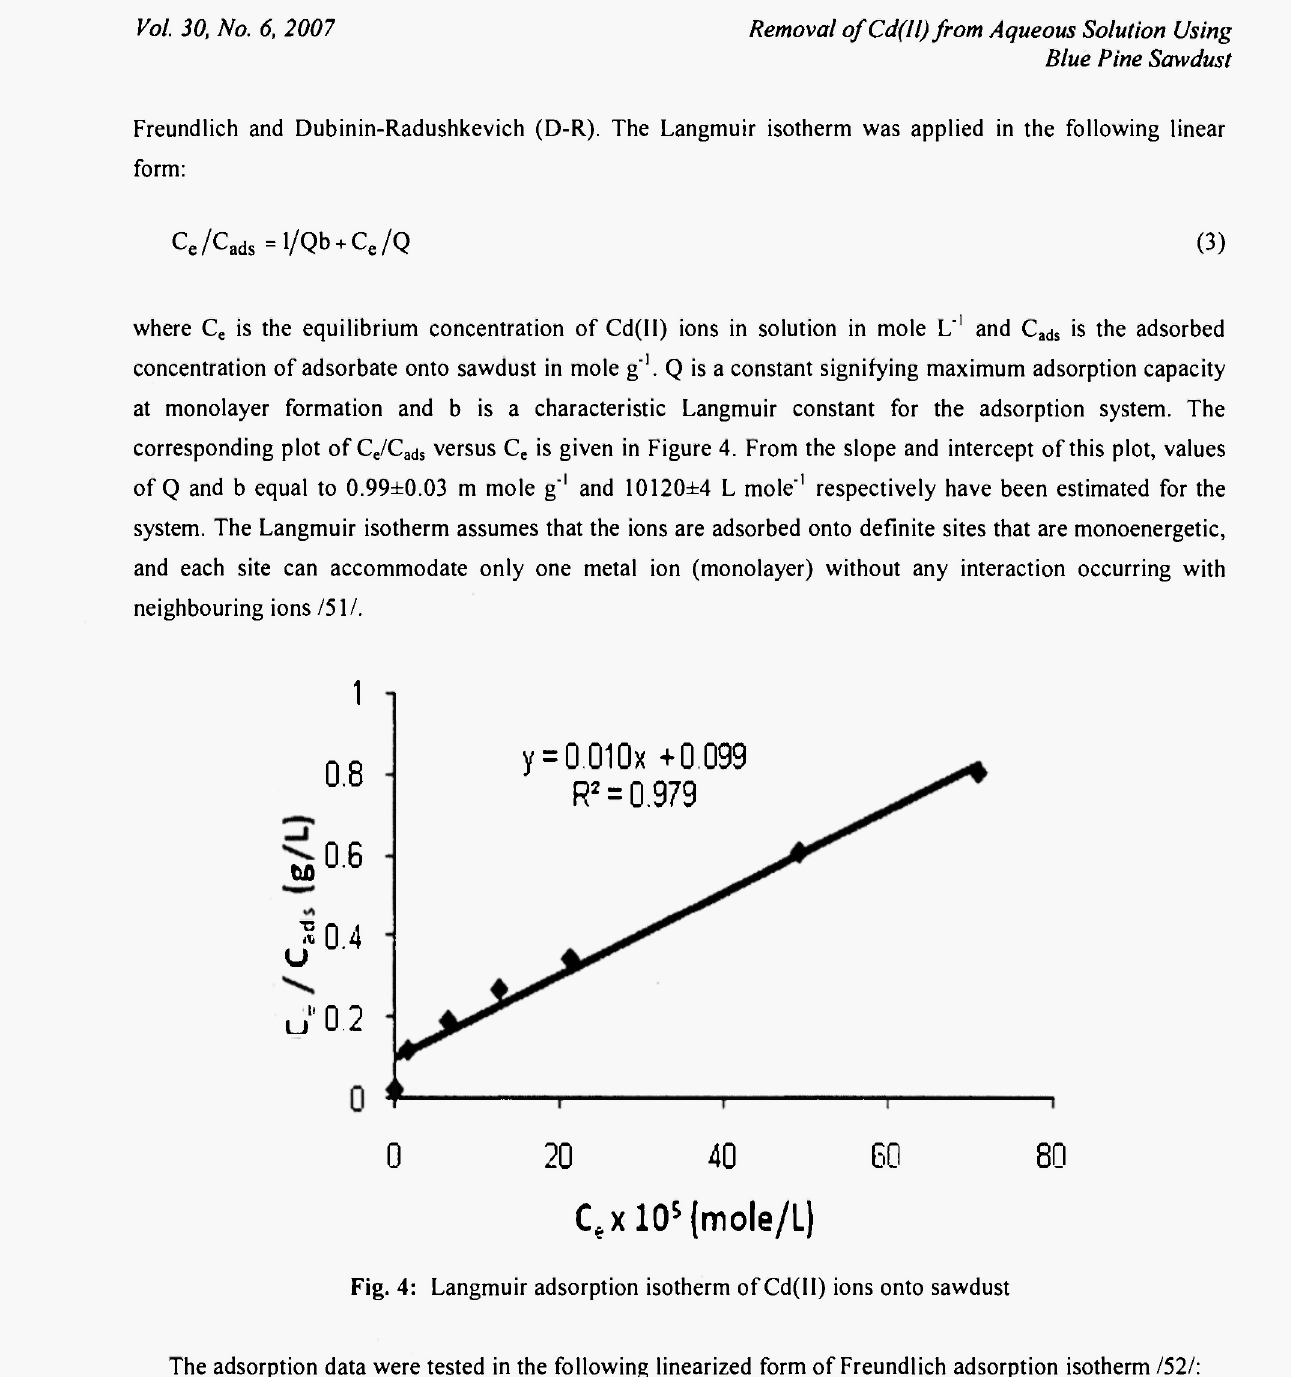
Fig. 4: Langmuir adsorption isotherm of Cd (II) ions onto